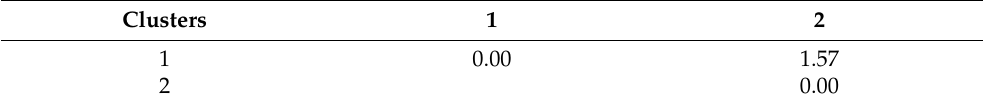
Table 10. Euclidean distance between clusters obtained by the k-means method for AcPh and AlPh. Clusters